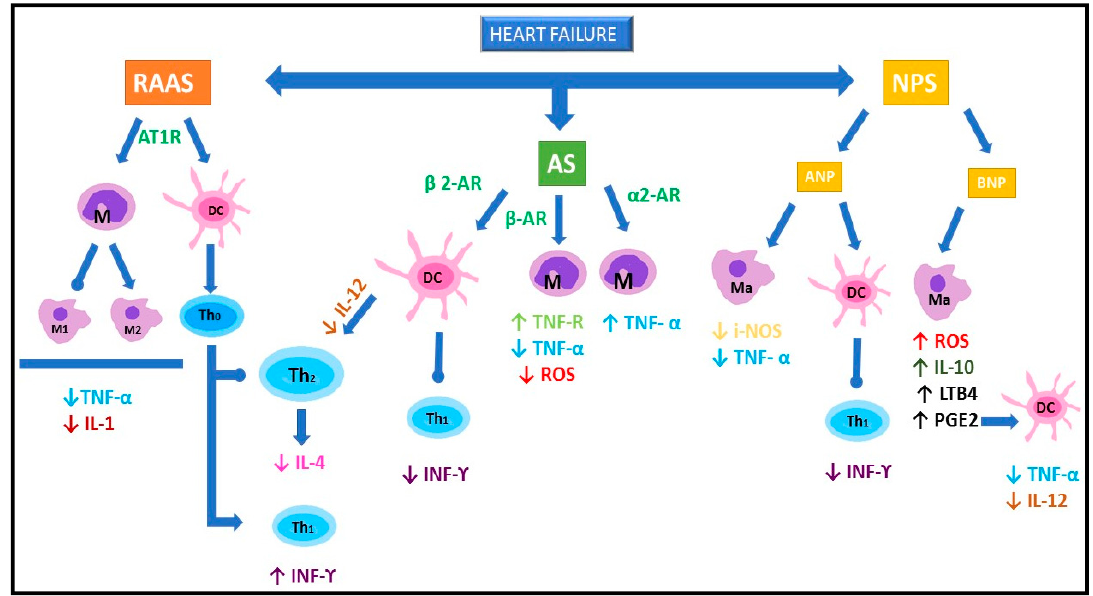
Figure 1. Effects of the neurohormonal system on the immune system . RAAS system : Angiotensin II (Ang II) regulates macrophage polarization, promoting M2 macrophages phenotype (M2). The consequent inhibition of M1 phenotype leads to a reduced release of TNF ‐α and IL ‐ 1. Moreover, Ang II preferentially promotes Th1 lymphocytes (Th1) differentiation through regulation of dendritic cells (DC), leading to increased INF ‐ ϒ levels. Inhibition of Th2 reduces IL ‐ 4 production and release. Adrenergic System (AS) : β and α 2 ‐ AR exert opposite effects on TNF ‐α release. β‐ AR activation in macrophages is responsible for the inhibition of ROS production, increase in TNF ‐α receptors, and reduction in TNF ‐α release. However, α 2 ‐ AR increase TNF ‐α release. In dendritic cells, activation of β 2 ‐ AR inhibits IL ‐ 12 production, resulting in inhibition of Th1 and promotion of Th2 differentiation. Natriuretic Peptide system (NPS) : ANP attenuates inflammatory responses by the reduction of TNF ‐ α release and nitric oxide production by iNOS. It also reduces the exacerbated TH1 responses. BNP PGE2. PGE2 is responsible of the inhibition of IL ‐ 12 and TNF ‐α release by dendritic cells.